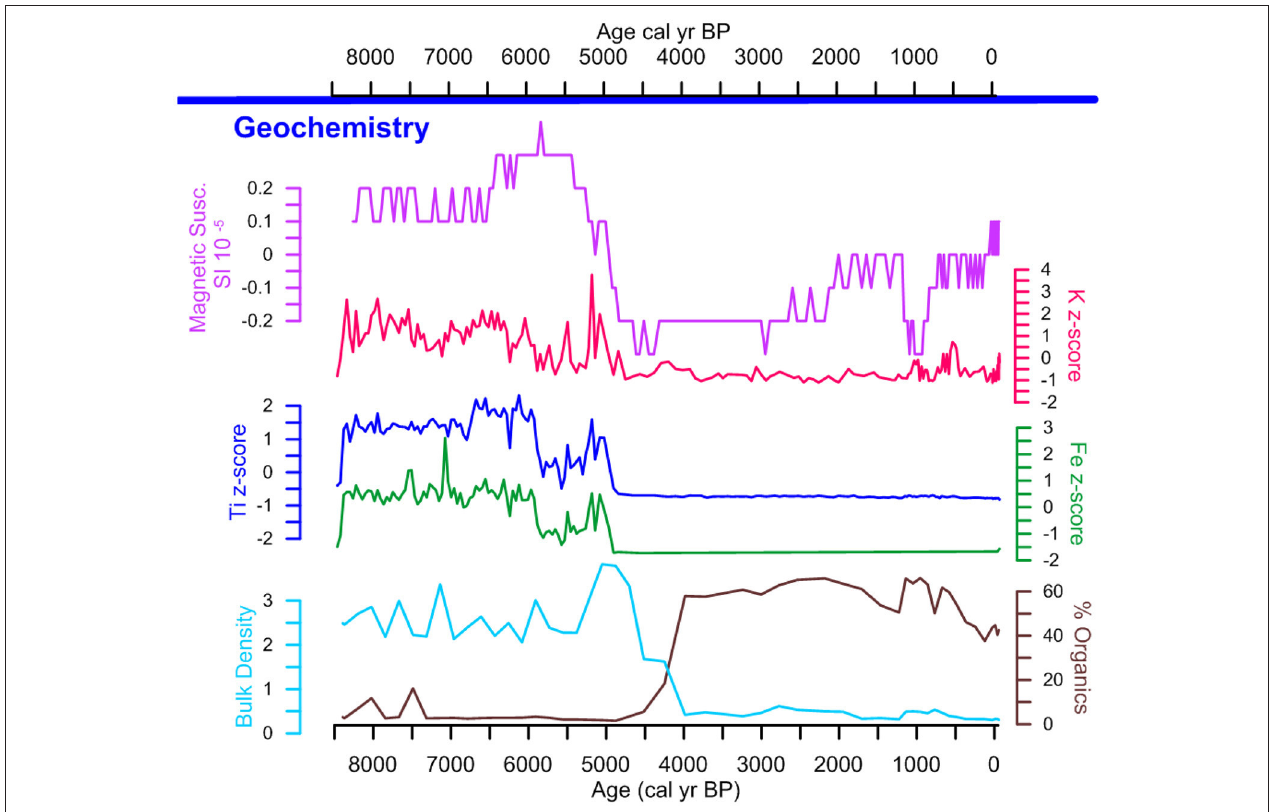
FIGURE 4 | Lago Caranã geochemistry. Geochemical proxies including magnetic susceptibility in purple, XRF z-scores for K in pink, Ti in blue, Fe in green, bulk density in teal and total organics in